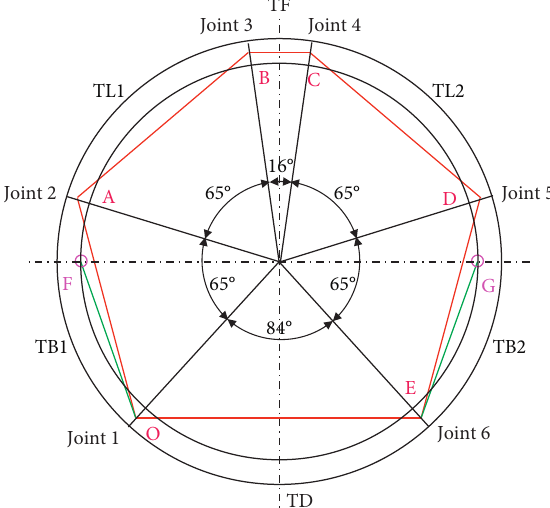
Figure 5: Lining ring of Shanghai metro shield tunnel. Points F and G are the measuring points of horizontal diameter convergence. Points O, A, B, C, D, and E are the rotation centers of each joint, not the middle points of the